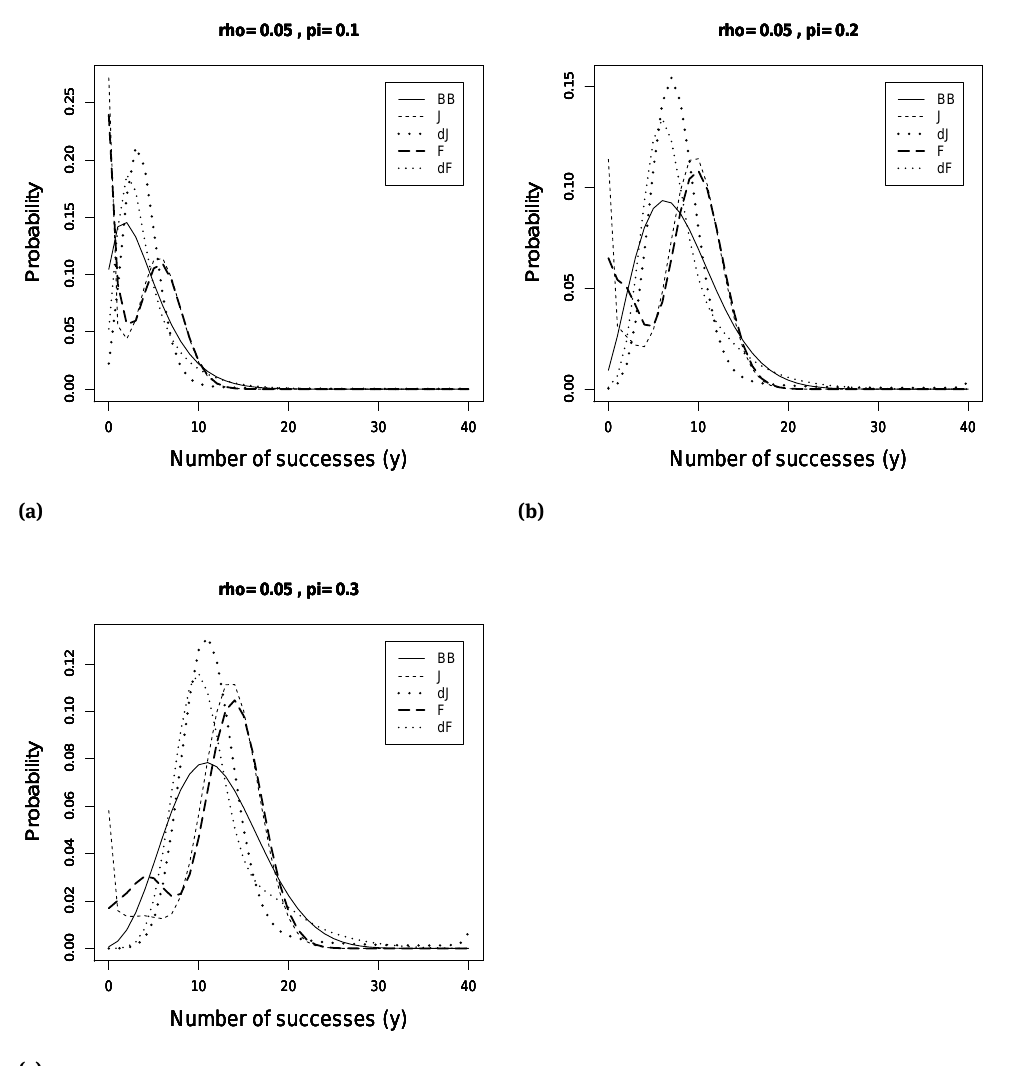
Figure 2: A comparison of the probability mass function for clusters of size 40 under the beta-binomial (BB), Joe (J), dJoe (dJ), Frank (F) and d-Frank (dIG), for ρ = 0.05 and π = 0.1( a ), 0.2( b ), 0.3( b